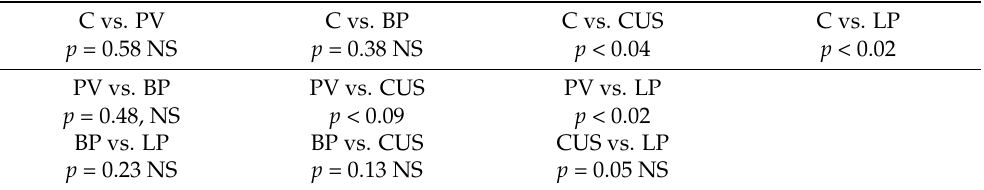
Table 1. Expression of STAT2 in study groups. C—control group; BP—pemphigoid; PV—pemphigus vulgaris; LP—lichen planus; CUS—chronic ulcerative stomatitis.